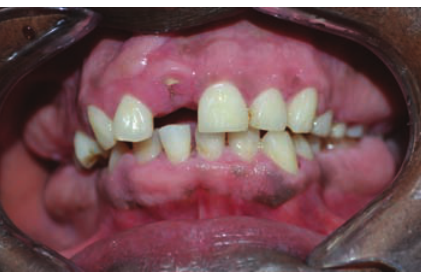
Figure 6: Clinical picture of 35-year-old brother with gingival